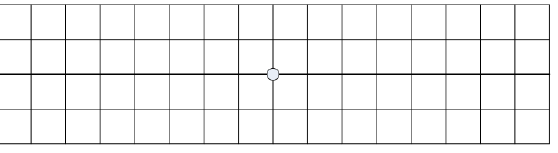
Figure 15. The regular fracture network. Table 3. Model